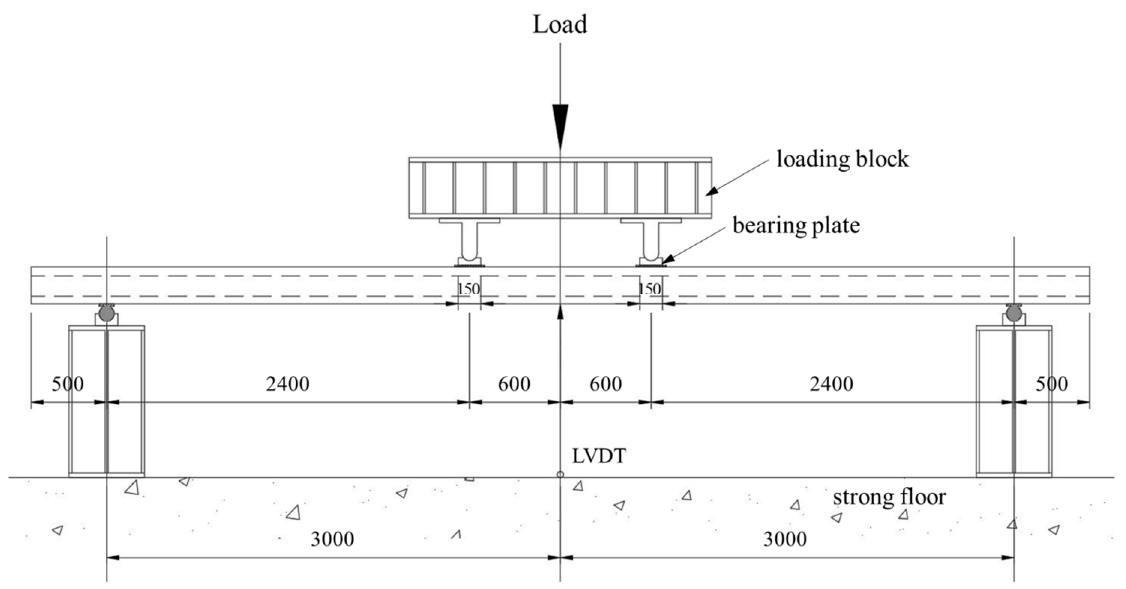
Figure 2. Experimental setup (all dimensions in mm).